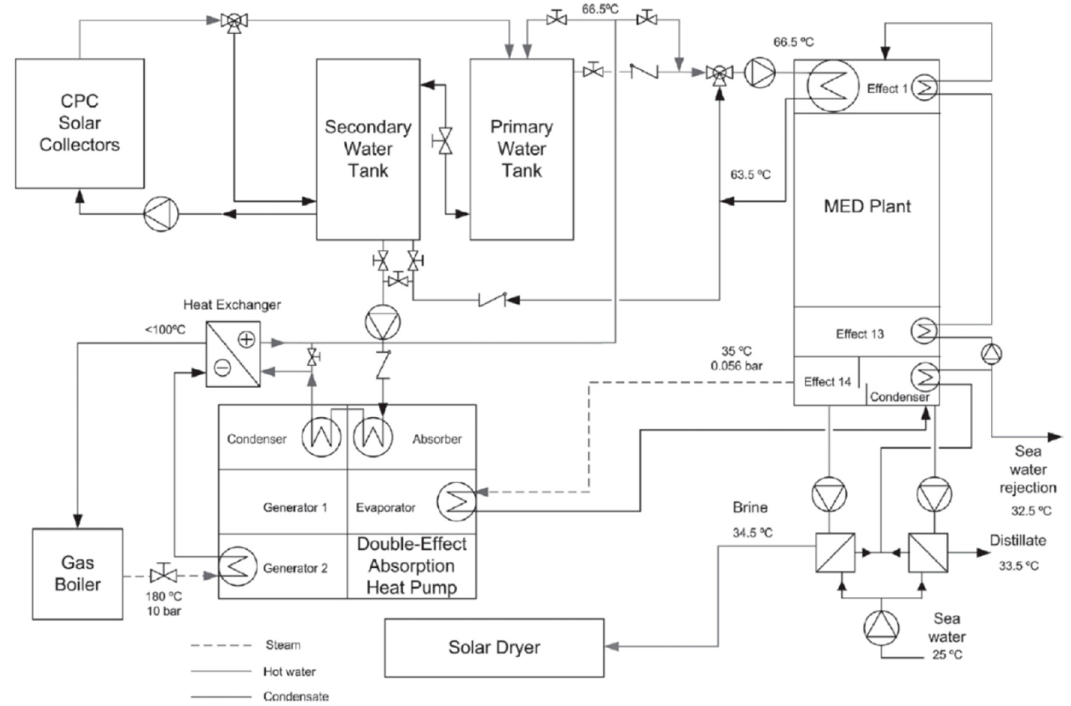
Figure 39. Configuration of AQUASOL seawater desalination system [74].